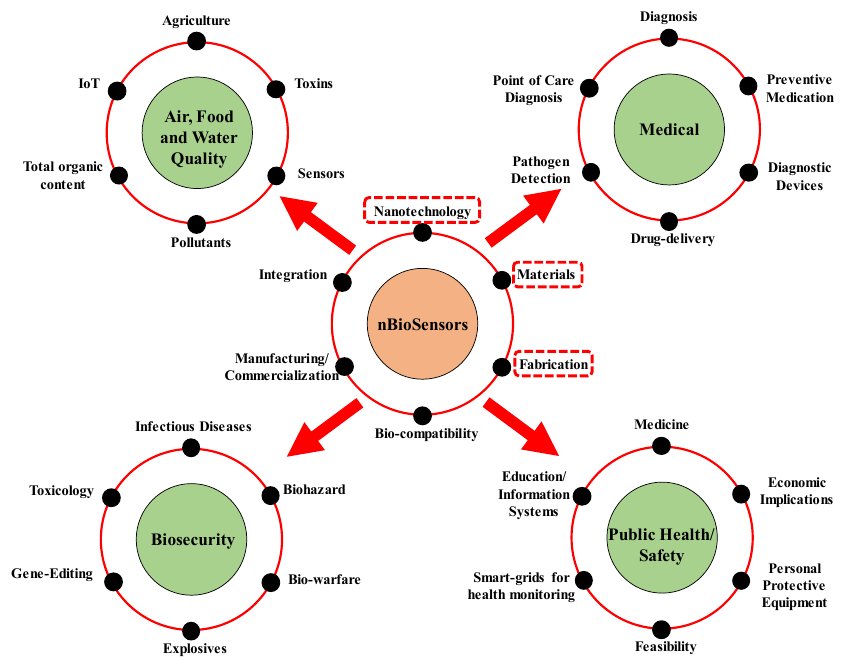
Figure 2. The field of research dealing with advancement in nano-biosensors is vast and comprises of a variety of multidisciplinary aspects. The primary applications of nano-biosensors can be broadly divided into the following fields: monitoring of air, food, and water quality, medical research, biose- curity, and public health and safety. These fields of research can be further subdivided into